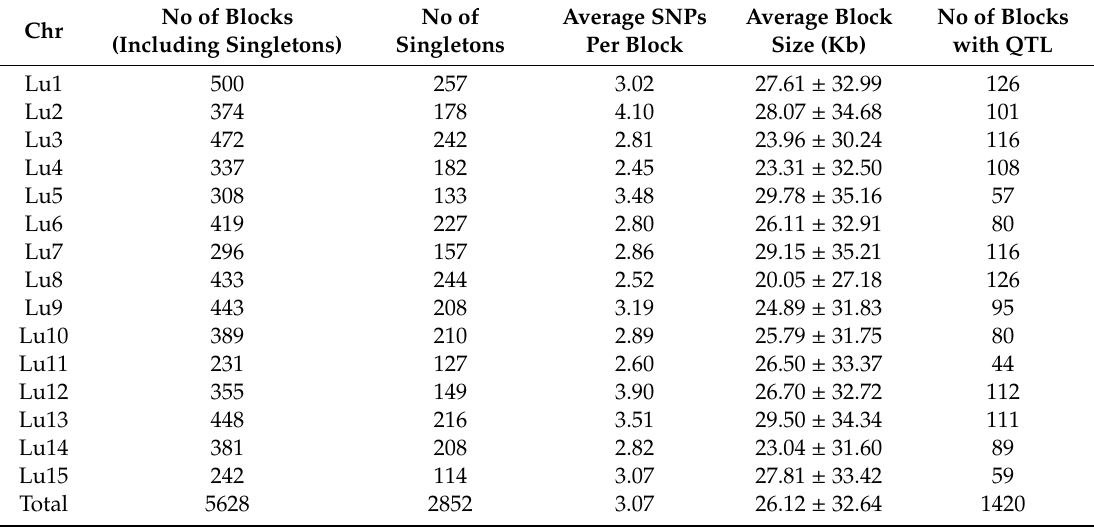
Table 1. The haplotype blocks identified from 17,277 single nucleotide polimorphsims (SNPs) in the 260 lines and association with quantitative trait loci (QTL) of